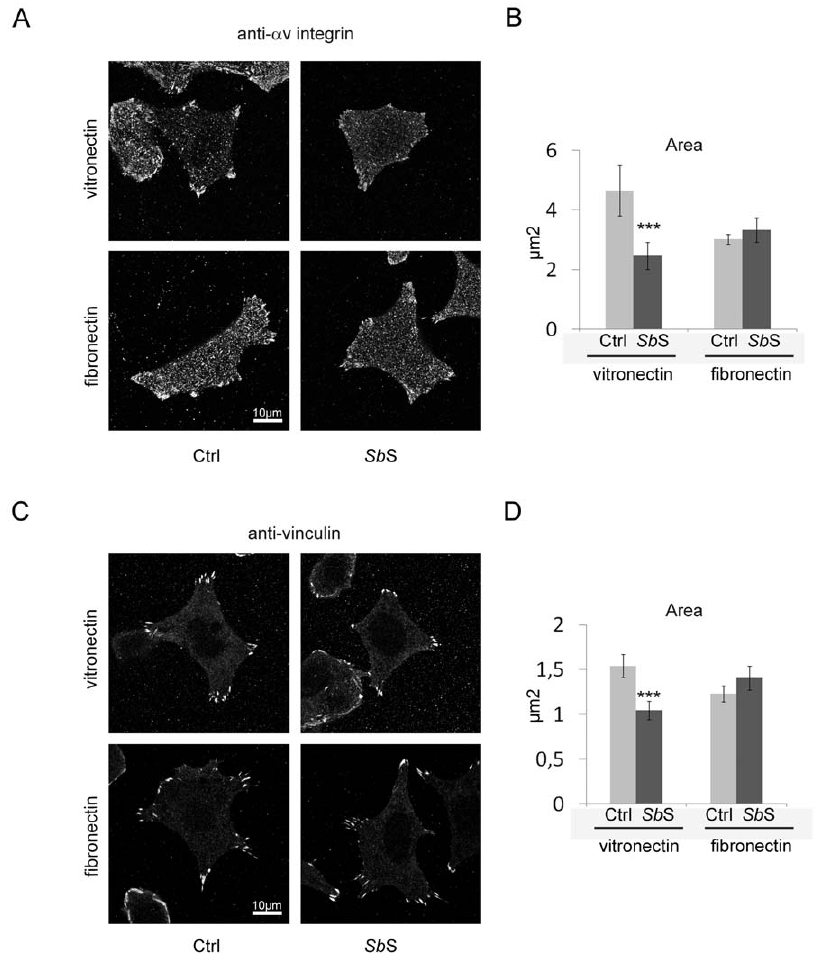
Figure 7. Sb S alters the organization of adherence structures when cells are plated on vitronectin. HCT-8/E11 cells were plated on either fibronectin or vitronectin for 2 h and then fixed. a v integrin (A) or vinculin (C) were detected using specific Abs. Focal adhesion labeling was quantified by measuring the area of each focal adhesion for all cells (B and D). Data represent the mean + SD of 3 separate experiments. *** P , 0.001.